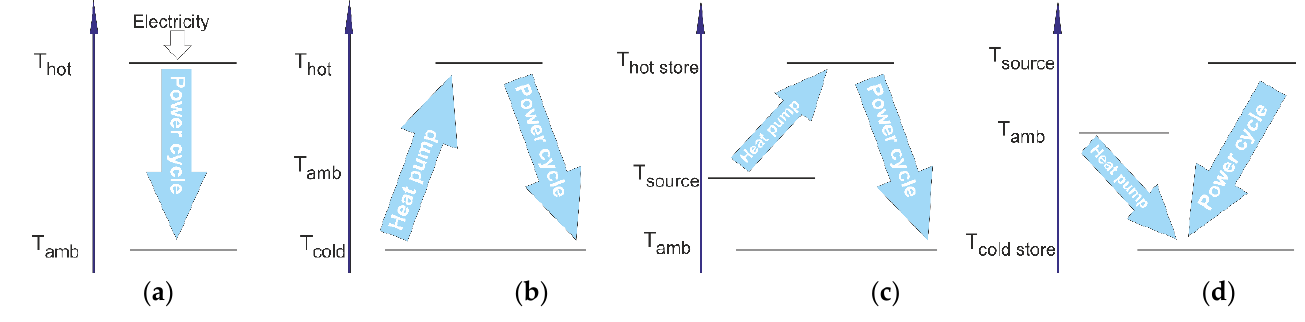
Figure 3. CB concepts regarding thermal integration of heat sources and conversion systems. ( a ) direct heat to power conversion, ( b ) reversible thermodynamic cycle, ( c ) with heat source integration and hot storage or ( d ) cold